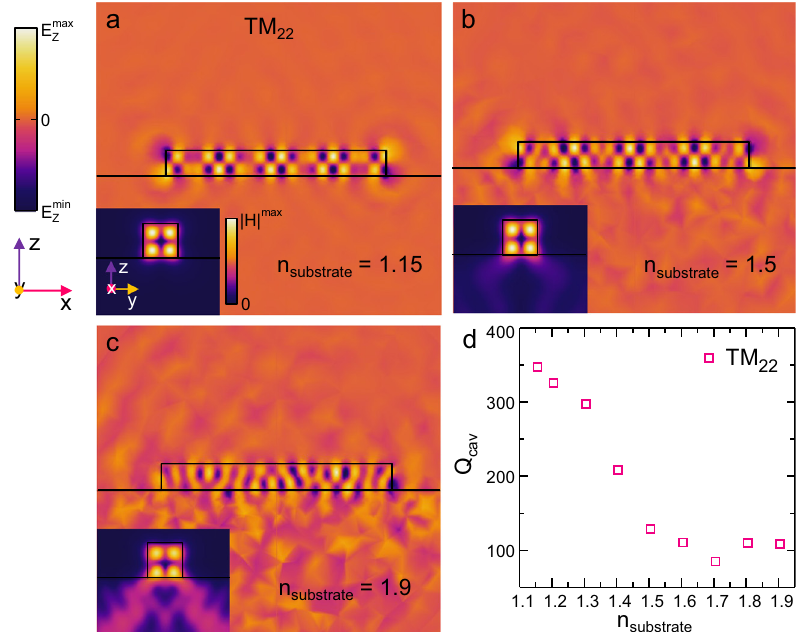
Figure 3: (a – c) Numerical modeling of the field spatial distribution of TM 22 eigenmode in CsPbBr 3 cavity with 3.5 × 0.4 × 0.4 μ